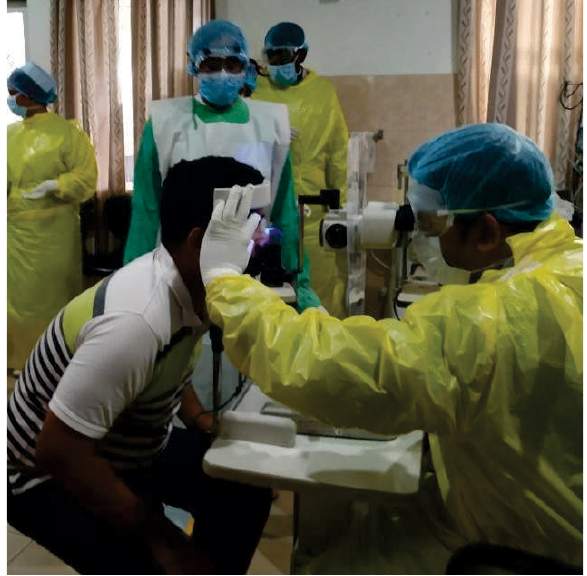
Figure 4: Patient examination - Casualty Room